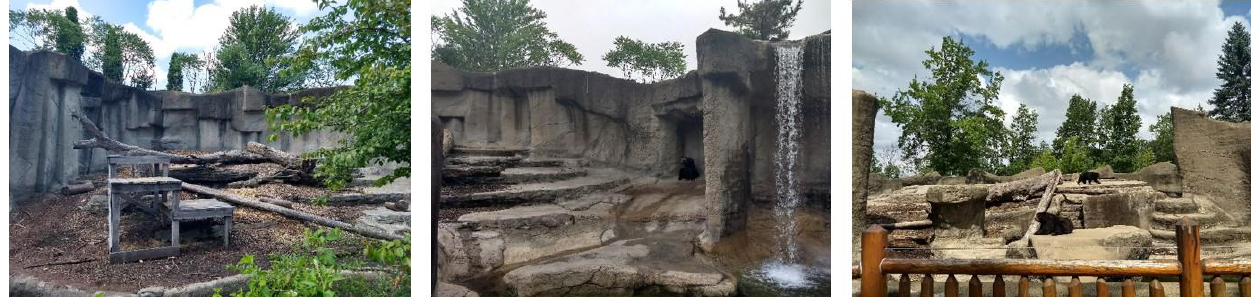
Temperate Bear Habitats, Left and Right